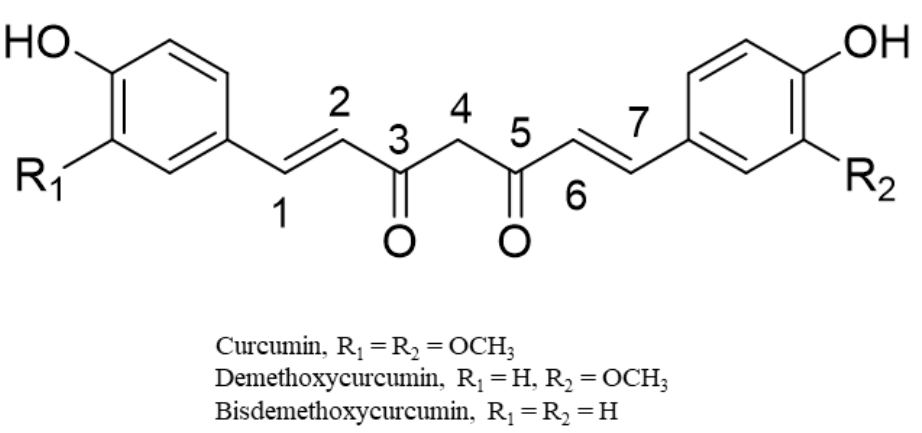
Figure 3. Representative chemical structures of the curcumin, demethoxycurcumin, and bisdemethoxycurcumin.